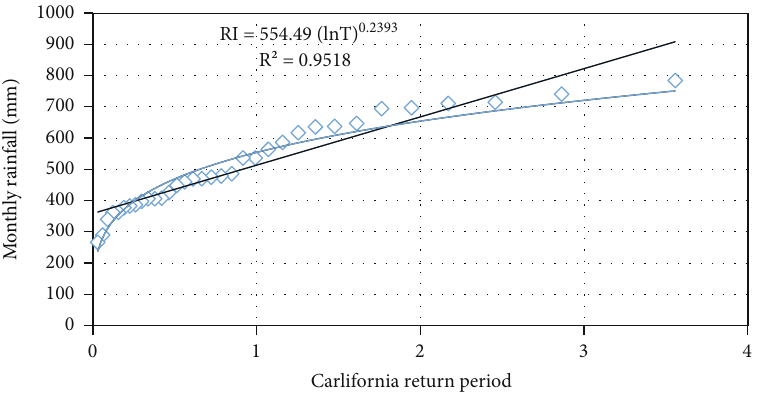
Figure 6: California ’ s probability plotting position.